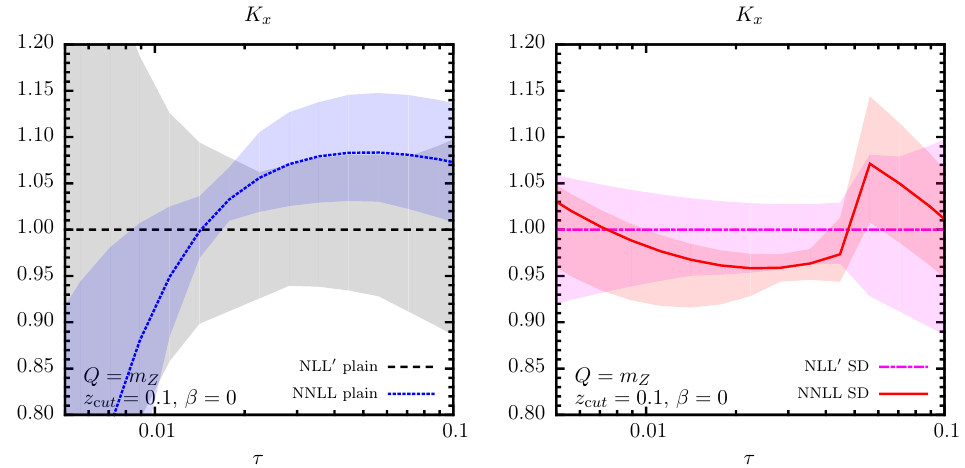
Figure 9 . Ratios of the all-order distribution computed at NNLL to its NLL 0 counterpart, on the left for plain thrust and, on the right, for soft-drop